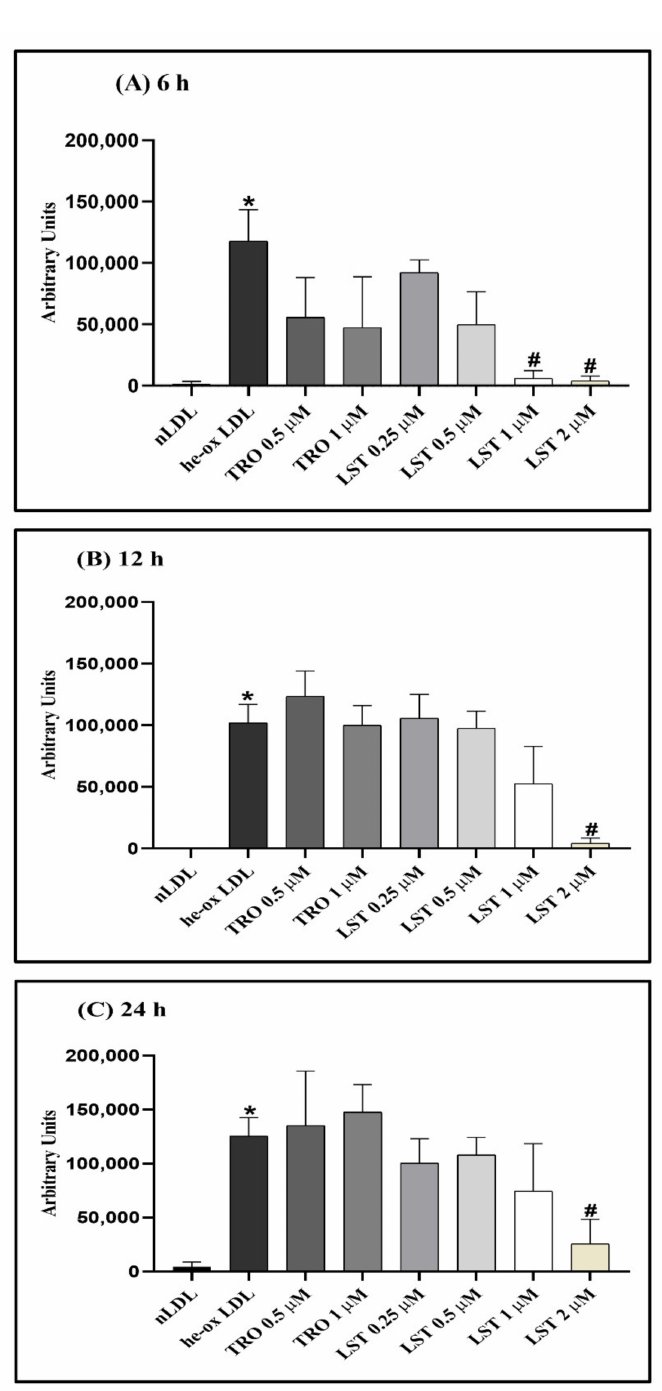
Figure 4. Effect of lusianthridin on oxidized lipid products detected at 234 nm: ( A ) at 6 h, ( B ) at 12 h, and ( C ) at 24 h in hemin-induced LDL oxidation. Data were presented as mean ± SEMs ( n = 4); * p < 0.05 vs . nLDL; # p < 0.05 vs .